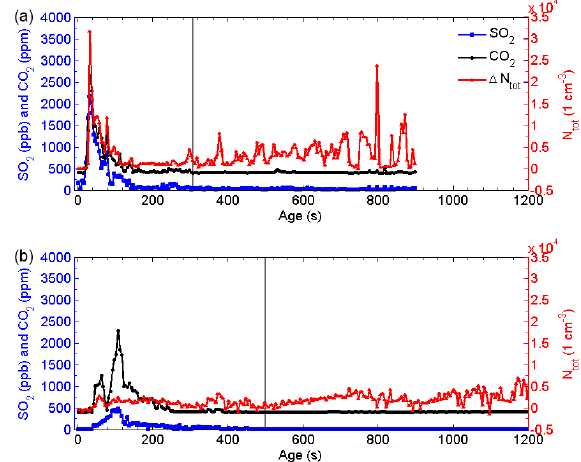
Figure 3. Concentrations of power plant flue-gas components mea- sured by instruments installed in the helicopter as a function of plume age; FGD + FF off in the top panel and FGD + FF on in the bottom panel. SO 2 (ppb, blue line) and CO 2 (ppm, black line) con- centrations on the left axes and total particle number concentration (cid:49)N tot (1cm − 3 , red line, from CPC) on the right axes. The (cid:49)N tot is calculated using the background value calculated from the upwind side of the stack (CO 2 , bg was 403ppm and SO 2 , bg 2–8ppb). The grey vertical lines denote 2km distance from the stack in FGD + FF on/off. The presented results are 5s median